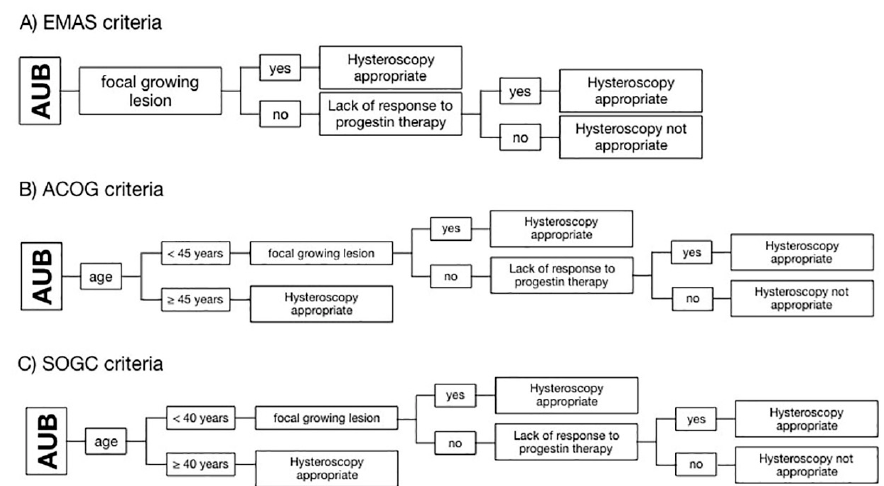
Figure 1. Schematization of the algorithms used to define hysteroscopic biopsy appropriateness according to the criteria of three di ff erent guidelines of scientific societies. ( A ) European Menopause and Andropause Society (EMAS); ( B ) American Congress of Obstetricians and Gynecologists (ACOG); and ( C ) Society of Obstetricians and Gynecologists of Canada (SOGC). Diagrams show that ACOG and SOGC consider the age of 45 and 40 years, respectively, as the first criterion of appropriateness.